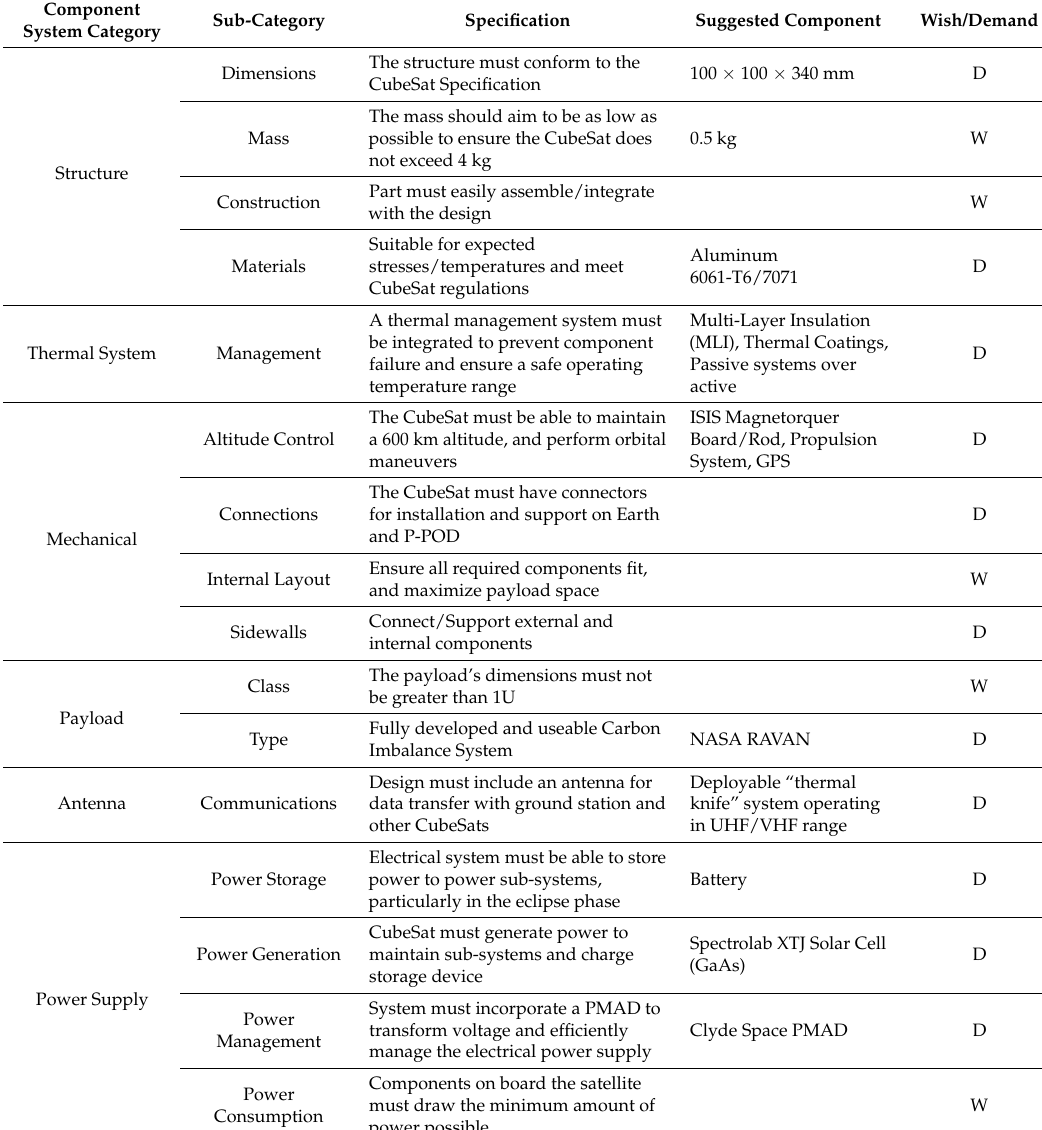
Table 22. 3U CubeSat Product Design